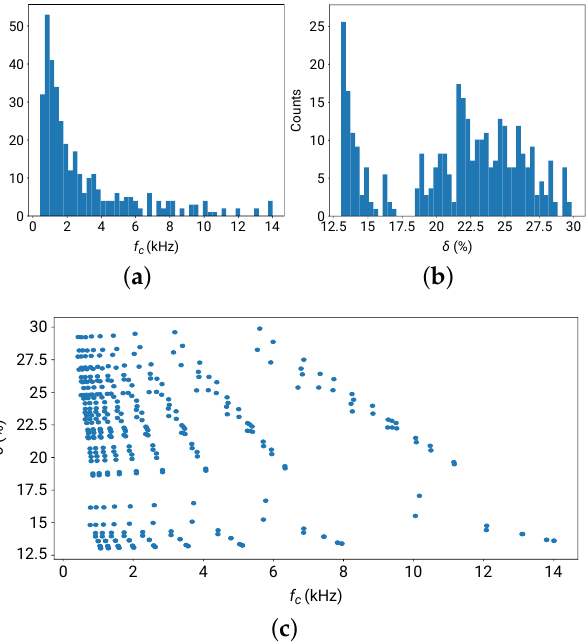
Figure 6. Distribution of the band gap frequency in the generated dataset. ( a ) Distribution of the center frequency f c . ( b ) Distribution of the normalized half-bandwidth δ . ( c ) Scatter plot of ( f c , δ )